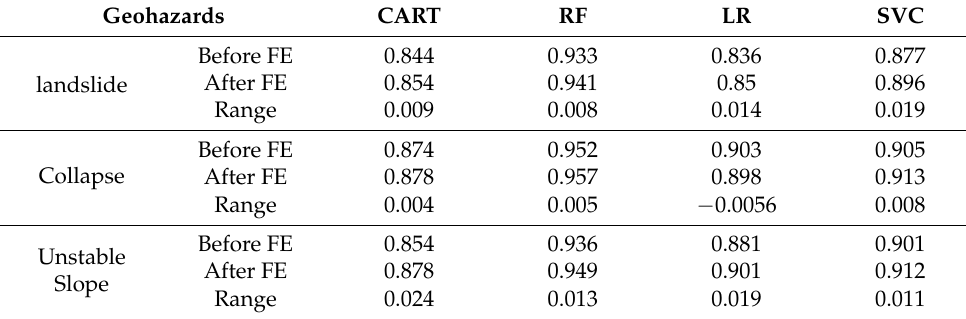
Figure 12. ROC curves of each model before and after the FE. Line I : results before the FE; ( I-a ): Landslide; ( I-b ): Collapse; ( I-c ): Unstable slope; Line II : results after the FE; ( II-a ): Landslide; ( II-b ): Collapse; ( II-c ): Unstable slope. Table 13. Changes in AUC of different methods before and after FE